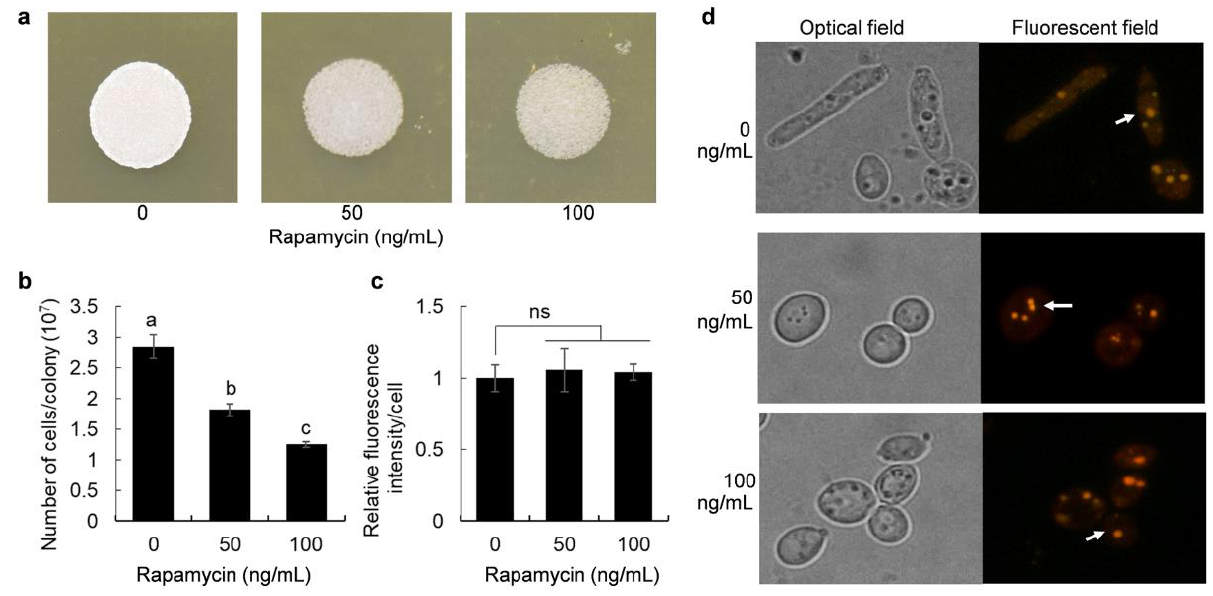
Figure 1. Impacts of rapamycin on cells growth and oils biosynthesis; ( a ) Colonies of the oleaginous yeast strain 2E00681 grown on YPD plates supplemented with different concentrations of rapamycin for 24 h; ( b ) Number of cells in the colonies; ( c ) Relative fluorescence intensity in cells; ( d ) Lipid droplets indicated by white arrows in the yeast strain 2E00681. Data are given as the mean ± SD, n = 3. One-way ANOVA was used to calculate the significant difference. Different letters (a, b, and c) marked on the charts are significant difference at p < 0.05. No significance was marked as ns.